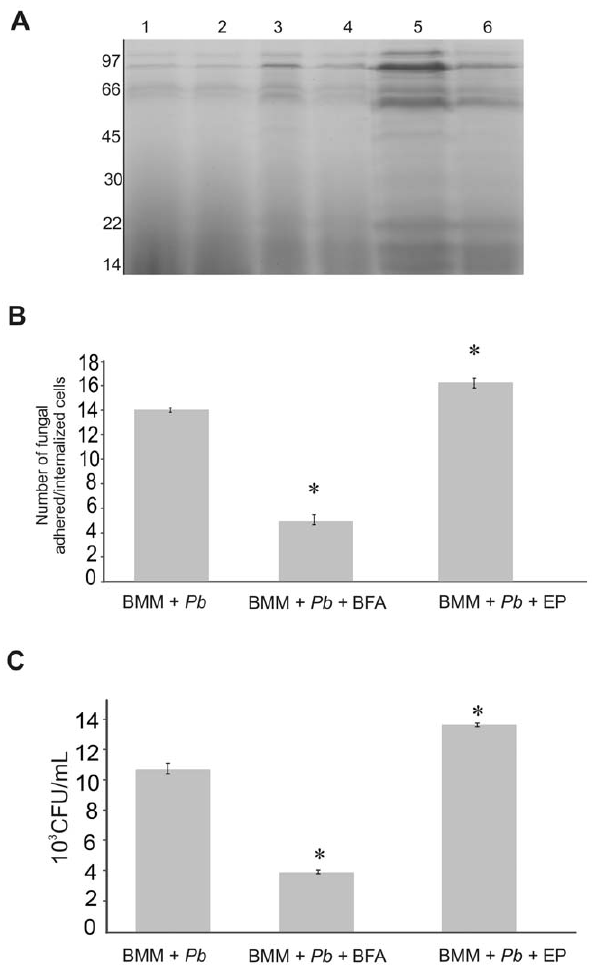
Figure 5. Blocking the conventional protein secretion pathway leads to a decrease in Paracoccidioides yeast cell phagocytosis. A - The protein profile of the cell-free supernatant samples reveals the effect of blocking the protein secretion pathway on yeast cells. Paracoccidioides yeast cells were cultivated in Fava Netto’s liquid medium in either the absence (control) (lanes 1, 3 and 5) or presence of Brefeldin A (BFA) at 6 m g/mL (lanes 2, 4 and 6) for 6, 12 and 24 hours, respectively. The cell-free supernatant samples were prepared (as described in the Materials and Methods section), reduced to equal final volumes (1 mL), and processed for one-dimensional electrophoresis (SDS-PAGE). Thirty microliters of each sample was separated via SDS- PAGE and visualized using Coomassie brilliant blue staining. The numbers on the left side correspond to the molecular mass standard. B - The average number of internalized/adhered Paracoccidioides cells by macrophages was determined. Macrophages were infected with Paracoccidioides yeast cells, which were pre-cultivated previously without BFA (control), in the presence of BFA or the presence of concentrated culture supernatant containing extracellular proteins (EP). The adhered/internalized cells were analyzed as described in the materials and methods section. C - The number of viable yeast cells after phagocytosis by macrophages was evaluated by counting the number of colony forming units (CFUs). The results are representative of triplicate biological samples. Statistical significance (* p # 0.05) was determined by comparing the results with the control